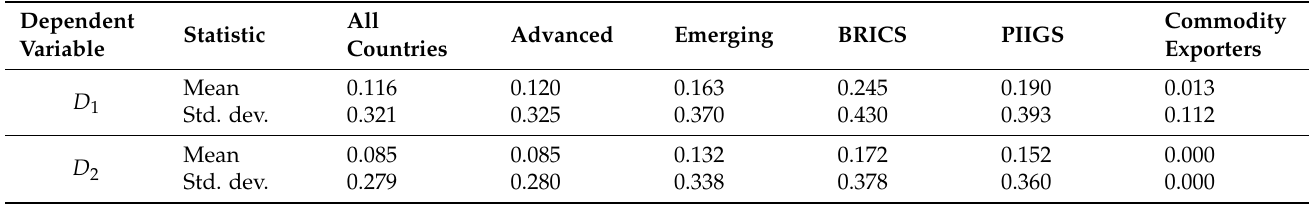
Table A1. Summary statistics of dependent